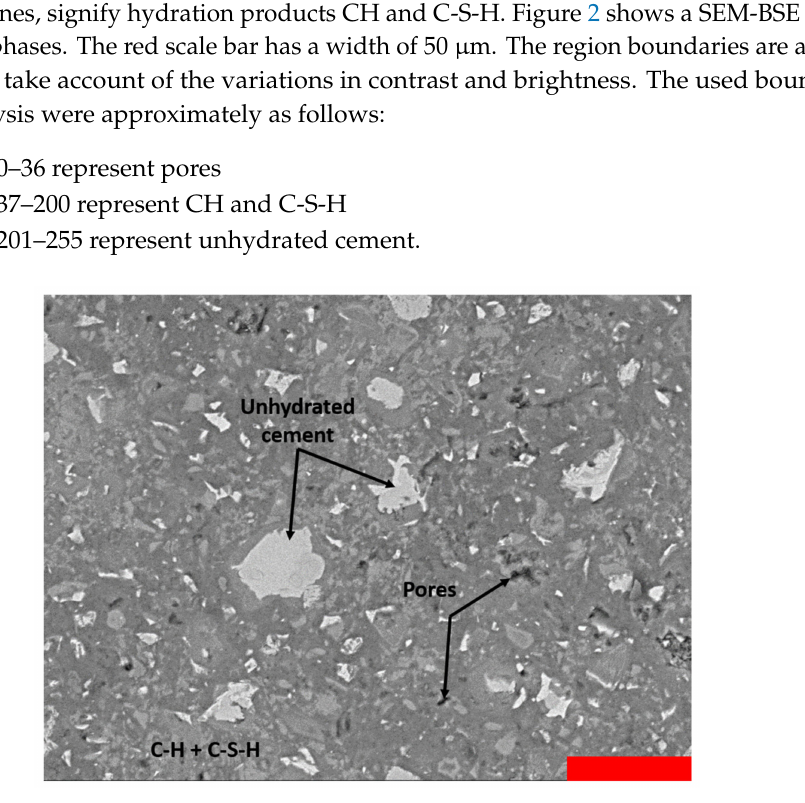
Figure 2. A SEM-BSE image illustrating the di ff erent phases of a cement paste. The red scale bar has a width of 50 µ